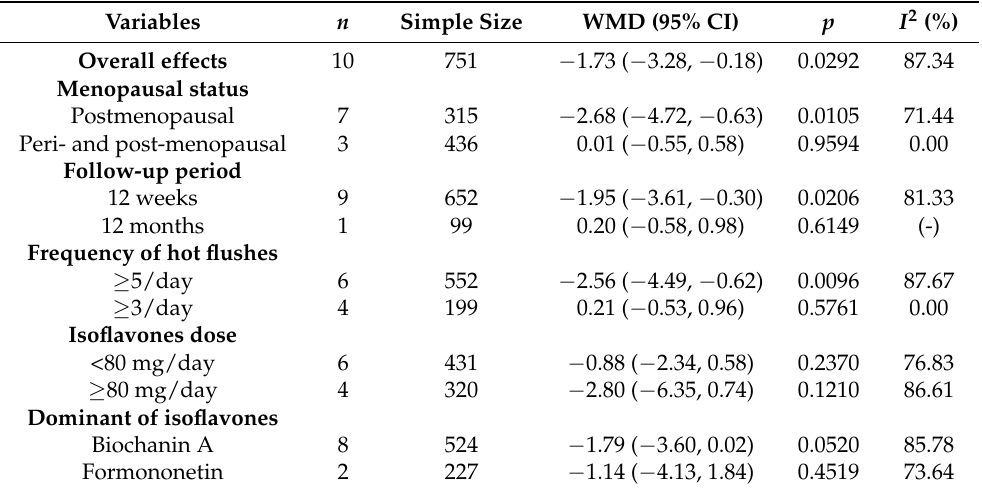
Table 2. Assessment of the effect of red clover isoflavones on the frequency of hot flushes in subgroup